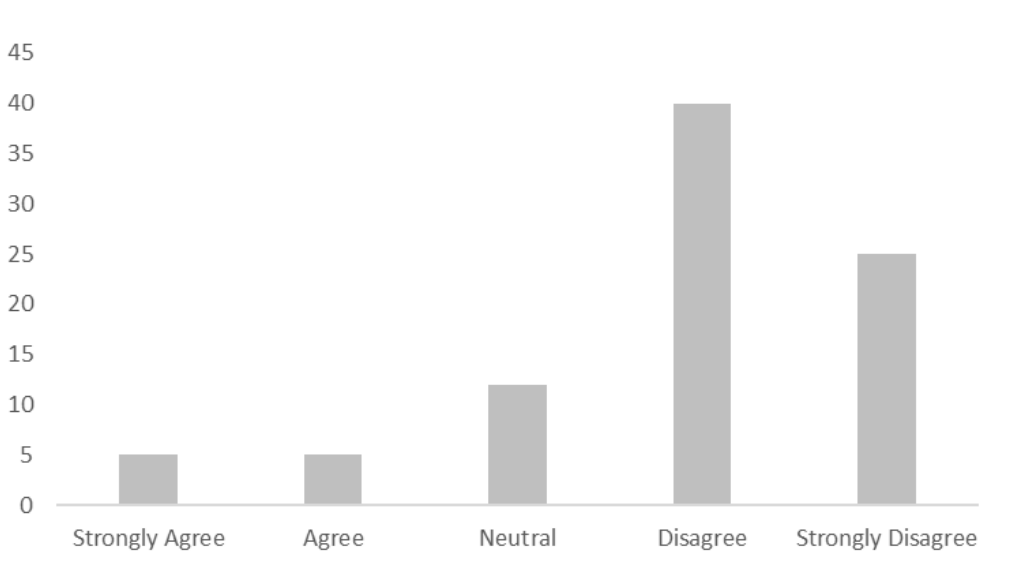
Figure 3. I would like my lecturers to make more use of the VLE (2015) The student voice states a clear disagreement with the association of VLE use with class disengagement: results from the full dataset indicate that 88% of students disagree or strongly disagree with the statement that ‘Getting notes on the VLE makes me less likely to go to